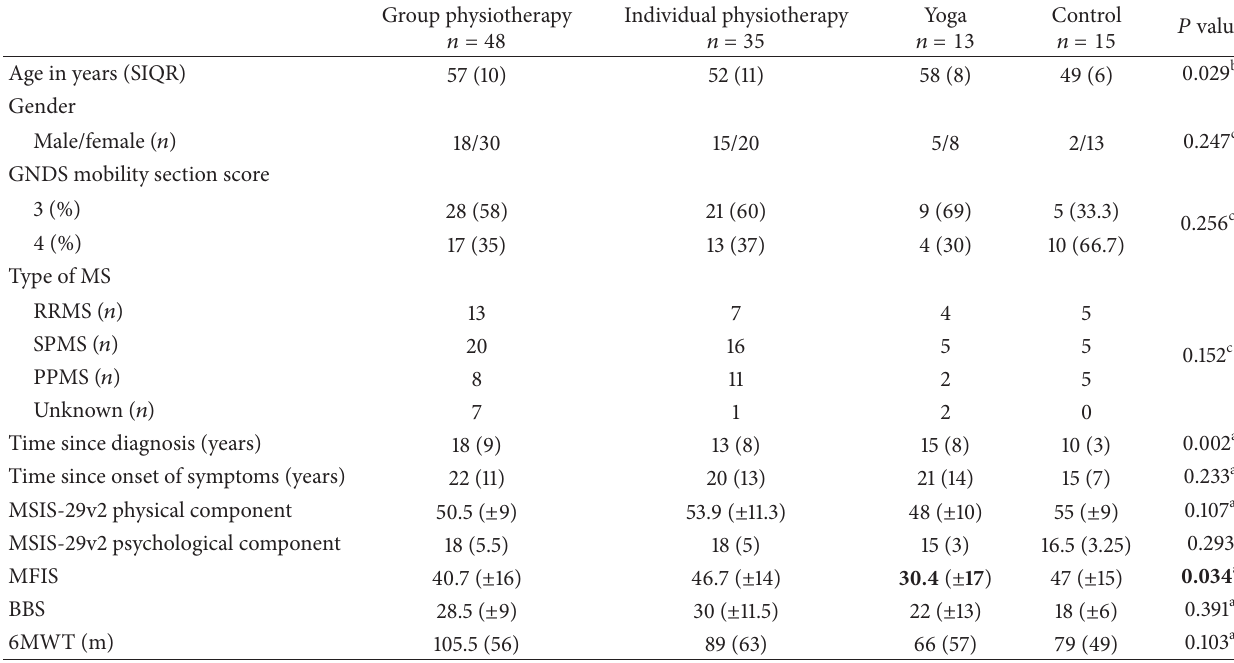
Table 2: Baseline comparisons between groups.